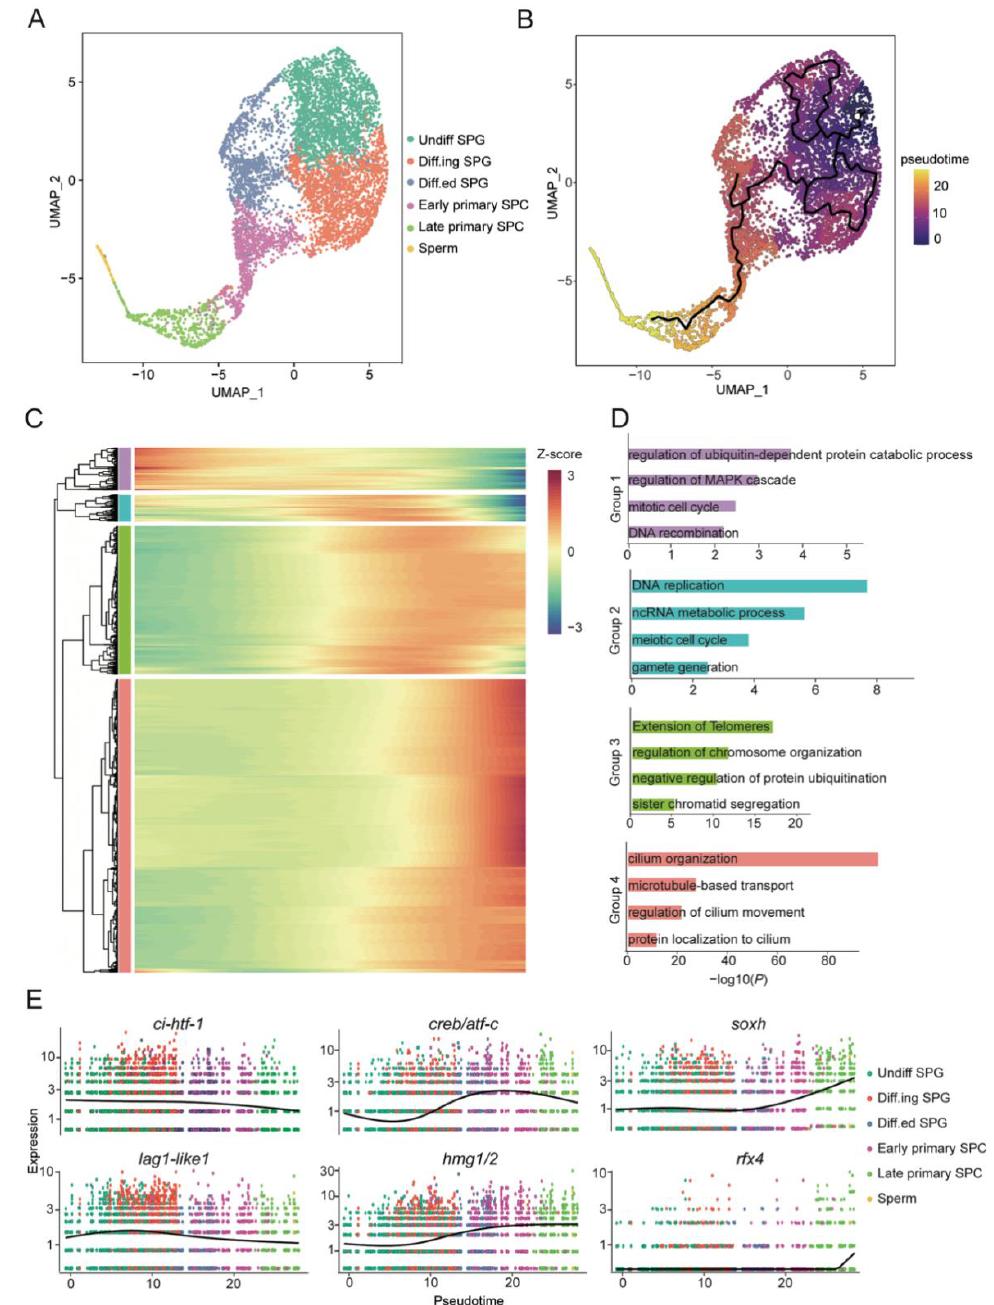
Figure 2. Gene-expression dynamics during spermatogenesis in C. intestinalis . ( A ) UMAP plot of 6 germ cell clusters. ( B ) Germ-cell pseudotime trajectories analyzed using Monocle3. Different colors indicate the differentiation degree of cell type (darker colors indicate lower differentiation degree). ( C ) K-means clustering of genes exhibiting differential expression (n = 1777) across germ-cell popula- tions. ( D ) Enriched terms for each gene group in ( C ). ( E ) Expression patterns of transcription factors during